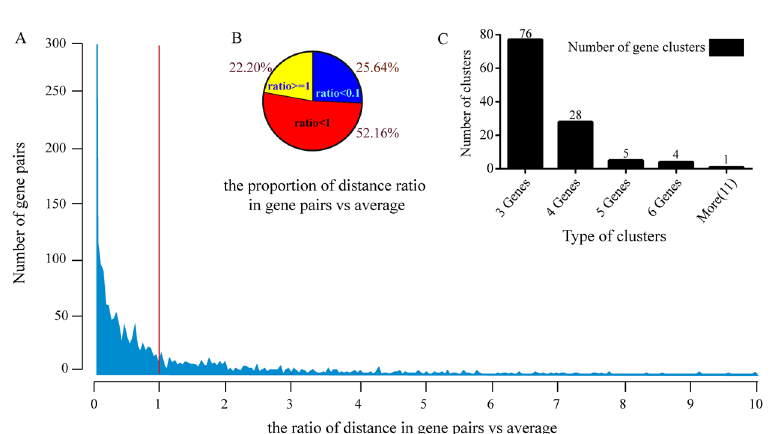
Figure 5. Clustering analysis of the differentially expressed genes (DEGs) in previous Omics studies. ( A ) Ratio of the practical interval between genes vs the expected distance. ( B ) Proportion of each distance ratio in gene pairs vs the expected. ( C ) Number of each gene cluster